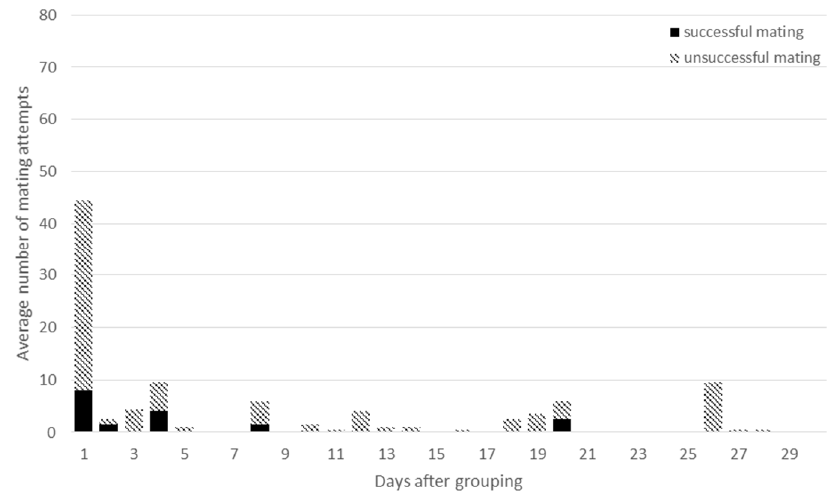
Figure 6. The average number of successful matings (dark column parts) and unsuccessful mating attempts (light column parts) in HET groups during the first month after assembling the groups.